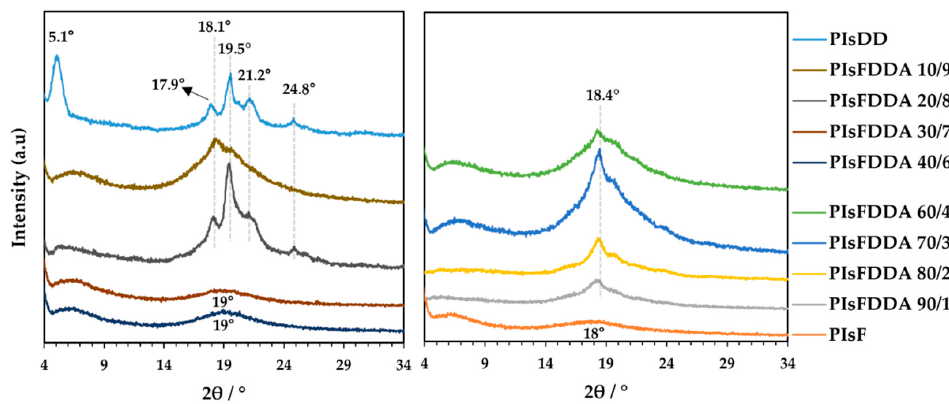
Figure 2. XRD patterns of PIsFDD copolyesters and related PIsF and PIsDD